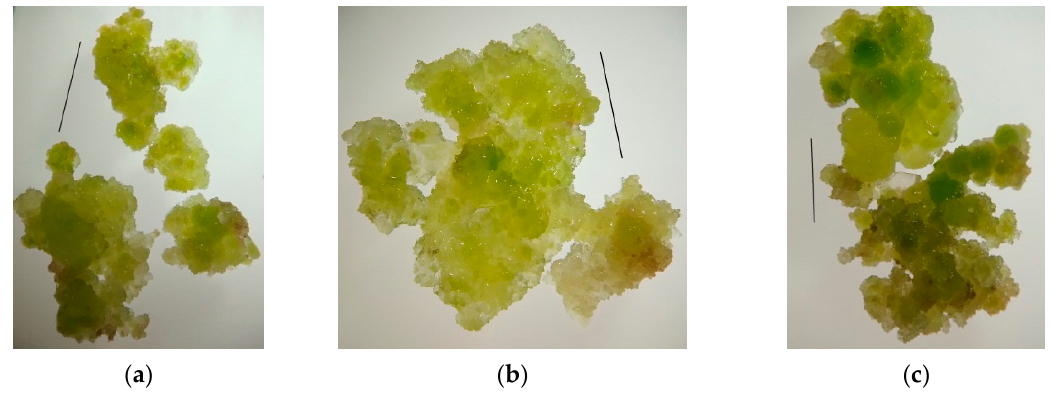
Figure 5. Appearance of callus tissue after cultivation under LED lamps of monochromatic spectrum: ( a ) blue LEDs; ( b ) green LEDs; and ( c ) red LEDs. Bars–0.5 cm. Flavonoid accumulation in S. hortensis callus tissue under the monochromatic light influence. Cultivation during the 5th subculture under monochromatic LED lamps did not result in significant changes in flavonoid accumulation (Figure 6).